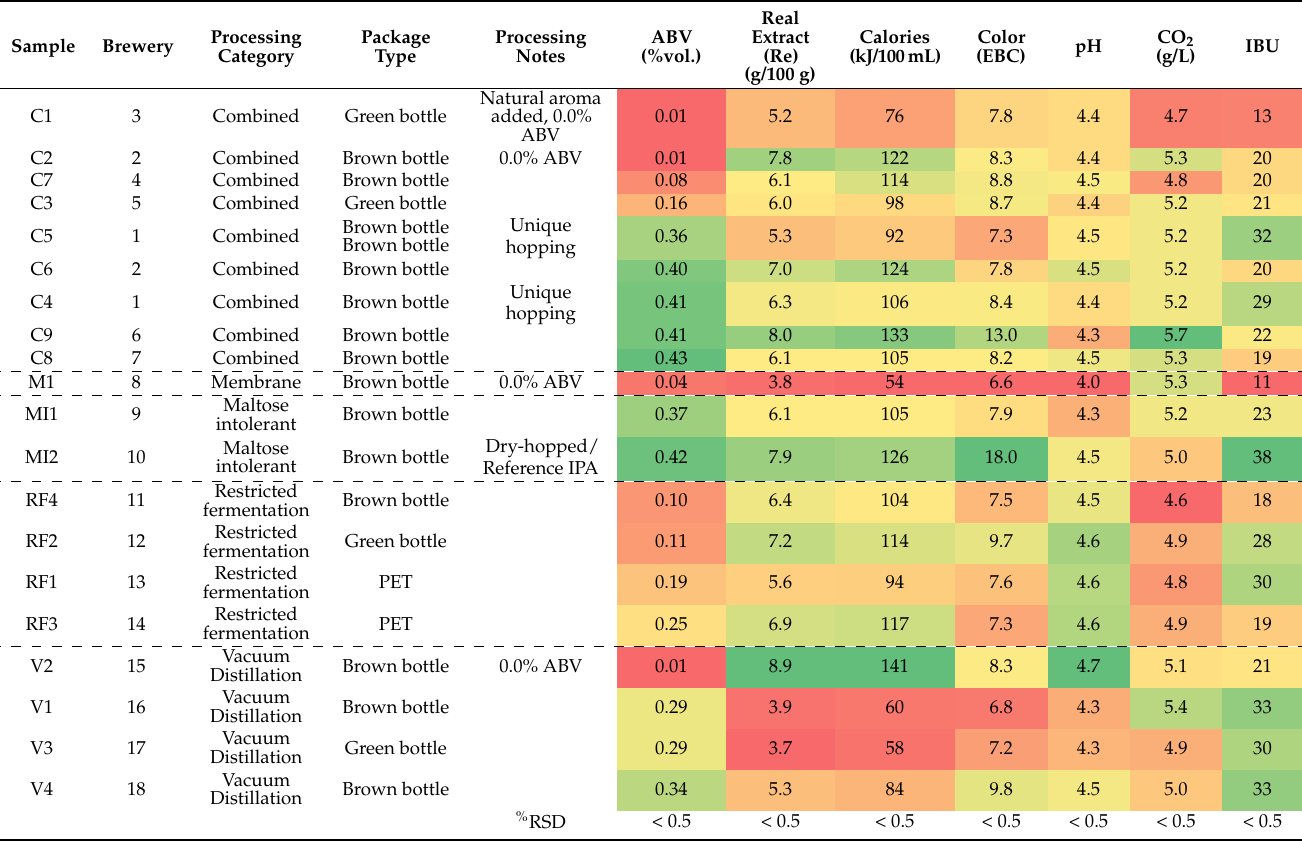
Table 1. Summary of basic chemical parameters of NAB grouped according to their production technique and sorted within production technique by